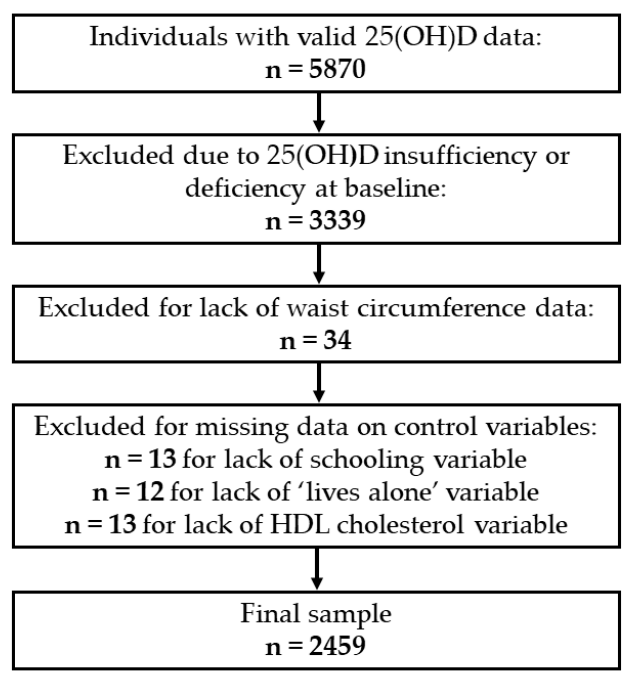
Figure 1. Selection of individuals at baseline (2012–2013). 25(OH)D, 25-hydroxyvitamin D.